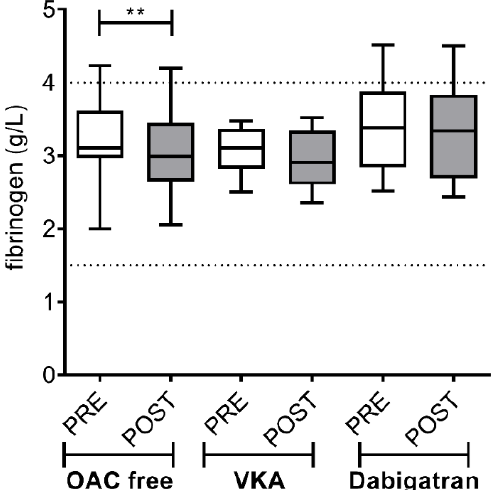
Figure 5. Left atrium fibrinogen levels before and after cryoballoon ablation procedure in AF patients on various pre-procedural anticoagulation strategies. Box and whisker plots indicate median, interquartile range, and total range. Dashed lines indicate lower and upper limit of reference interval (1.5–4 g/L). PRE (empty bars): pre-ablation, POST (solid bars): post-ablation, OAC: oral anticoagulant, VKA: vitamin K antagonist. ** p < 0.01.